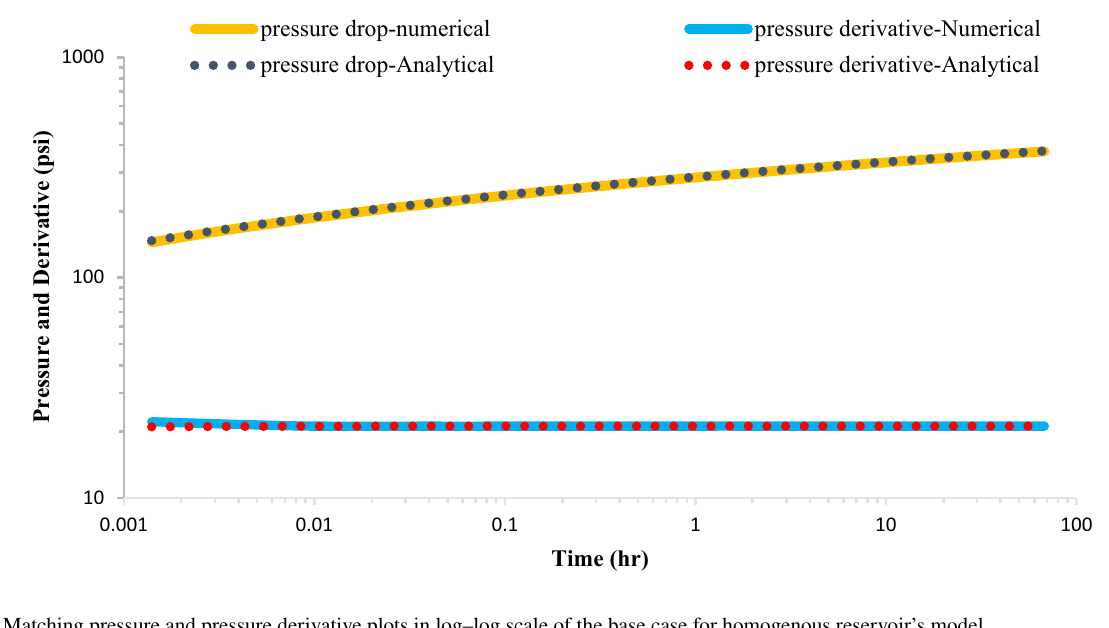
Fig. 3 Matching pressure and pressure derivative plots in log–log scale of the base case for homogenous reservoir’s